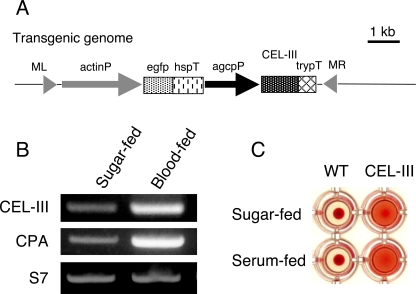
Structure of the CEL-III Gene and Its Expression in Transgenic Mosquitoes(A) Schematic diagram of the pMinos-EGFP-carboxypeptidaseP-CELIII-antryp1T construct used for A. stephensi germ line transformation. The construct consists of the D. melanogaster actin5c promoter (actinP), egfp selectable marker (egfp), and D. melanogaster hsp70 terminator sequence (hspT), the A. gambiae carboxypeptidase promoter sequence (agcpP) plus its signal sequence (SP), fused in-frame to the coding sequence of CEL-III without its signal sequence followed by the A. gambiae trypsin terminator sequence (trypT). The left (ML) and right (MR) arms of Minos are indicated by triangles.(B) Induction of CEL-III mRNA by a blood meal. Transgenic mosquitoes were allowed to feed on a non-infected mouse and 6 h later total RNA was extracted from midguts of engorged mosquitoes (Blood-fed). As a control, total RNA was extracted from midguts of sugar-fed mosquitoes (Sugar-fed). CEL-III mRNA level was examined using RT-PCR. PCR products of the endogenous carboxypeptidase gene and the S7 gene were used as inducible positive controls and quantitative controls of the different mRNA preparations, respectively. These PCR products were fractionated by electrophoresis then stained with ethidium bromide.(C) Hemolytic activity of midgut contents of transgenic mosquitoes. Transgenic (CEL-III) and non-transgenic (WT) mosquitoes were offered a serum meal by membrane feeding. Six h after the meal, the supernatants of midgut lysates were added to human erythrocytes. Hemolytic activity was determined by visual examination of lysis of erythrocytes as described in Figure 1A.